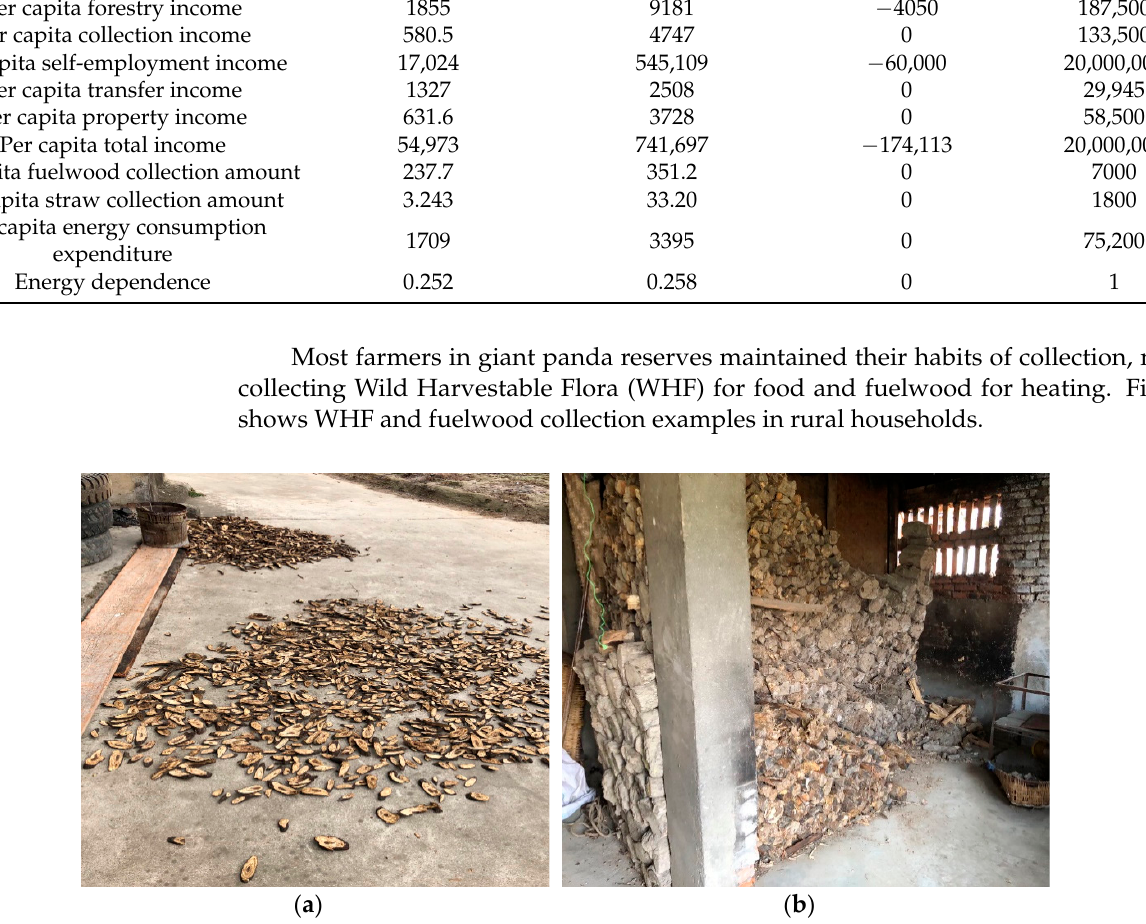
Table 1. The source of income and natural resource dependence of farmers. Variables